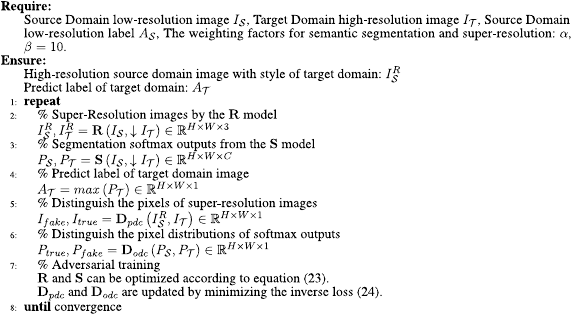
Algorithm 1. the proposed